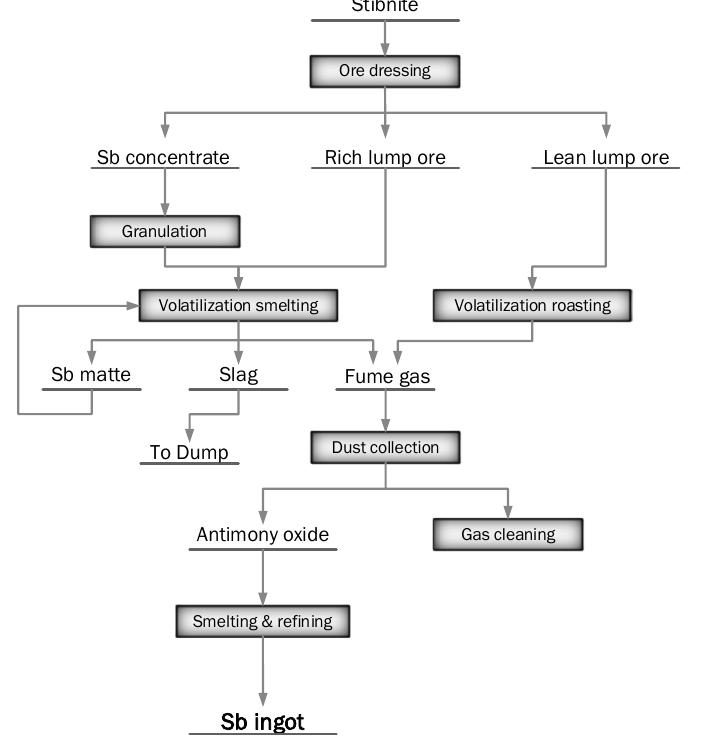
Figure 6. Flow diagram of volatilization smelting of stibnite in blast furnace-reverberatory furnace (adapted from [19]).